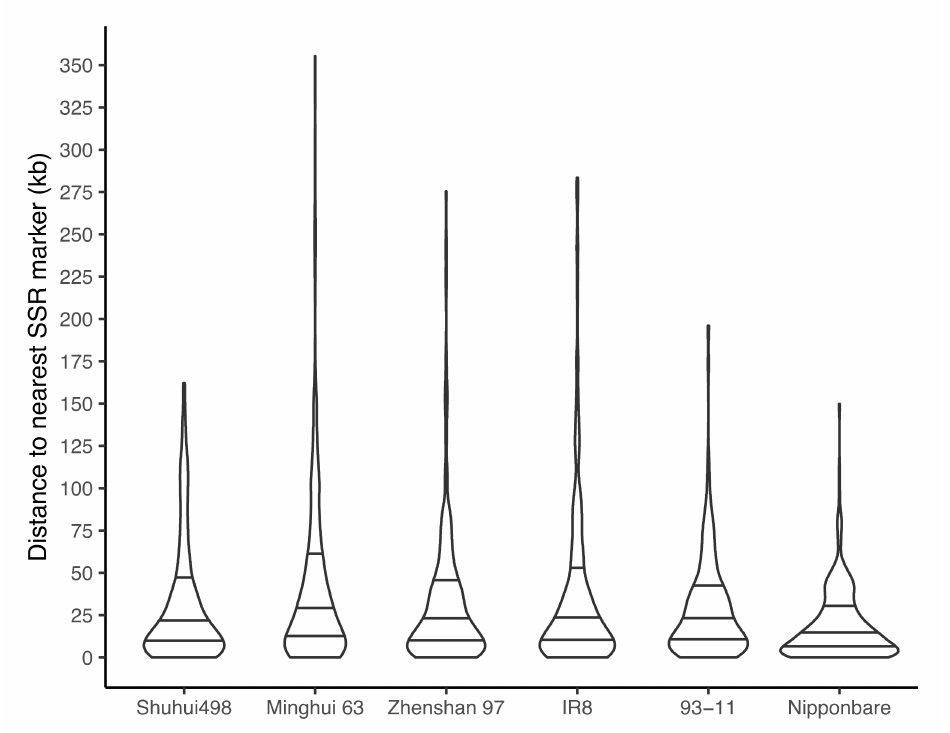
Figure 4. Distance of candidate R-genes and R-pseudogenes from the nearest SSR marker (listed in Gramene, Available online: www.gramene.org (accessed on 10 January 2019) in the six reference genomes analysed. The shape of the violins illustrates the distribution of distances each reference genome, horizontal lines indicate the first quartile, median, and last